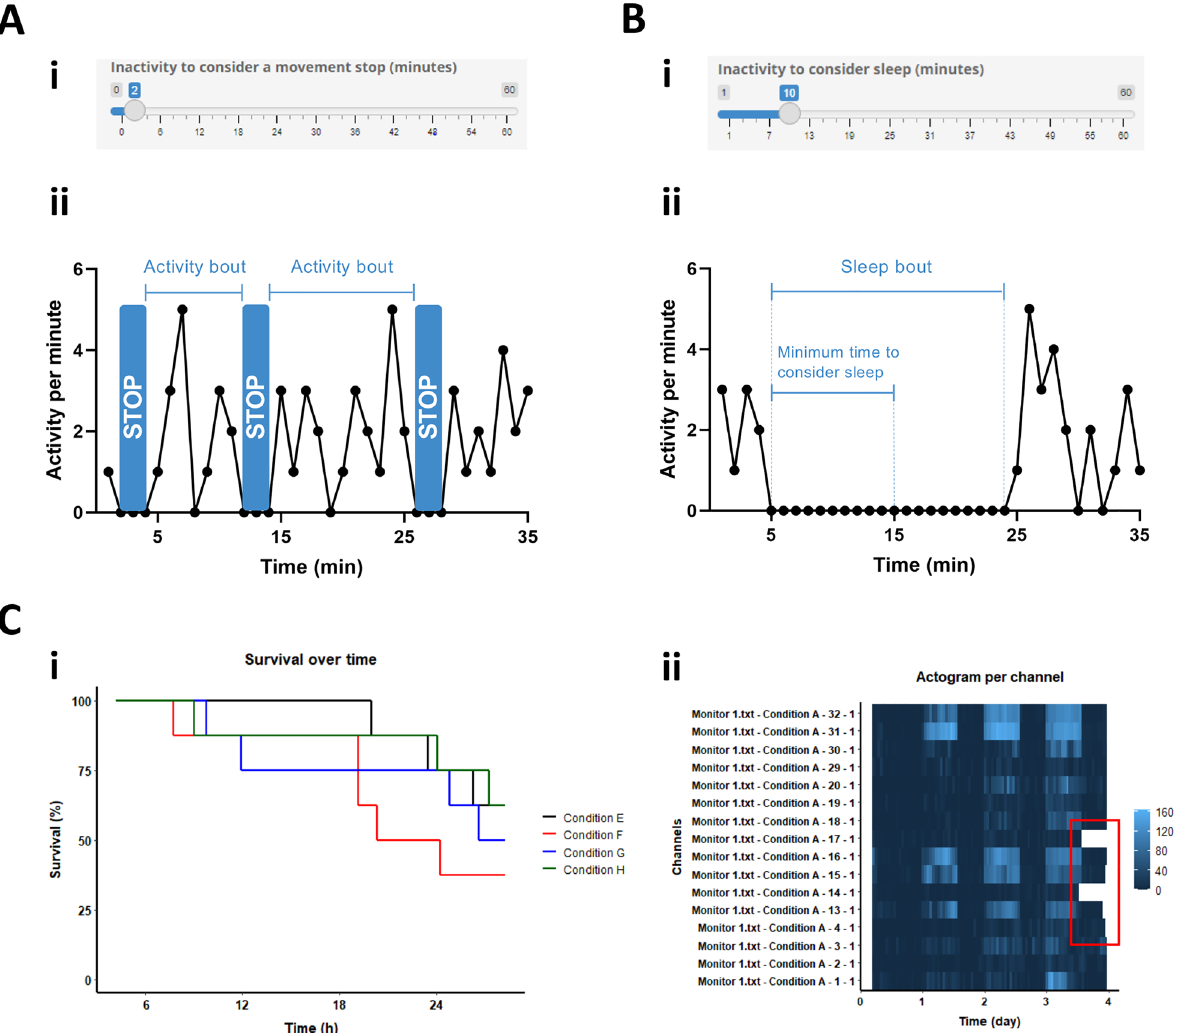
Figure 2. Inactivity parameters. ( A) Movement stops and activity bouts: (i) user-defined inactivity threshold to consider a movement stop; ii) representation of activity bouts between two movement stops. ( B) Sleep and sleep bouts: (i) user-defined inactivity threshold to consider that an animal is asleep; ii) representation of a sleep bout between two timepoints with non-zero activity. ( C) Survival analysis: (i) survival percentage over time (Kaplan–Meier plot); (ii) representative actogram per channel, where the last inactivity periods are excluded from the representation (white sections inside the red rectangle). Data are from individual zebrafish larvae; time 0 equals 4 days post fertilization (dpf). Images in Figure contain screenshots of the Rtivity software developed in this study (https:// ruisi lva. shiny apps. io/ rtivi ty/), assembled and illustrated by co-authors RS and JMAO using version 2.8.22 of the free image editor GIMP (https:// www. gimp.